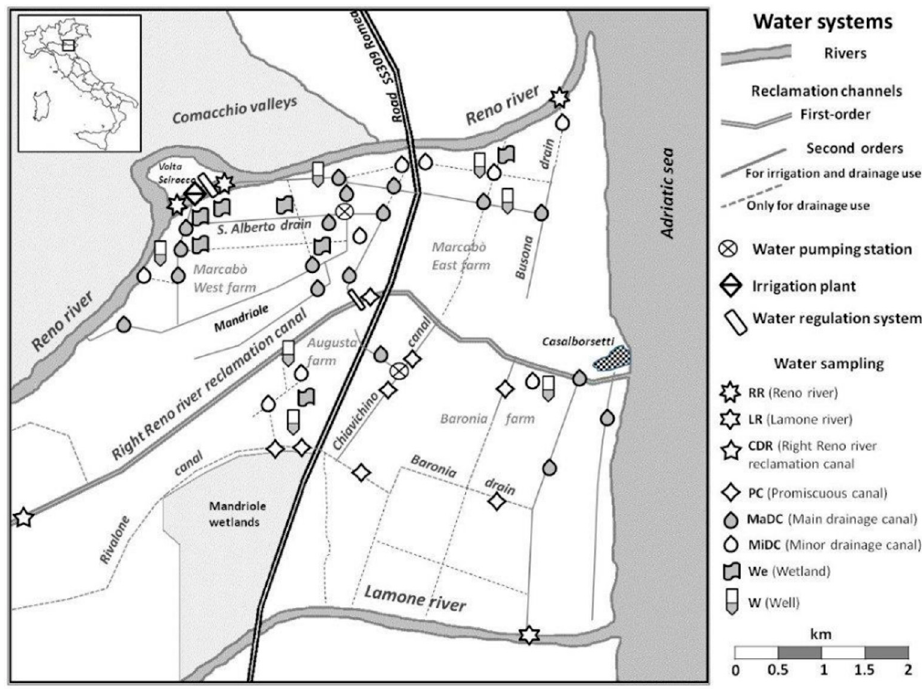
Figure 3. Map of the water bodies and network of artificial canals in the study area (from Cipolla et al. [21]).